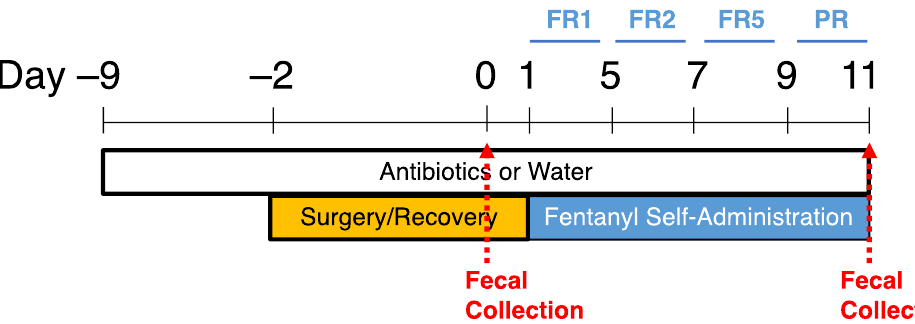
Figure 6. Experimental timeline for antibiotic treatment, fentanyl self-administration, and fecal sample collection. Animals were provided drinking water plus antibiotics or drinking water only (controls) and maintained their assigned treatment throughout the entire experiment. Following one week of antibiotic or water treatment, animals were implanted with intravenous catheters and given 2 full days to recover from surgery before starting self-administration. Animals self-administered fentanyl at fixed ratio (FR) 1 for 5 days, FR2 for 2 days, FR5 for 2 days, and progressive ratio (PR) for 2 days, for 11 days total. One fecal sample was collected from each animal the day before self-administration (day 0) and the last day of PR (day 11).